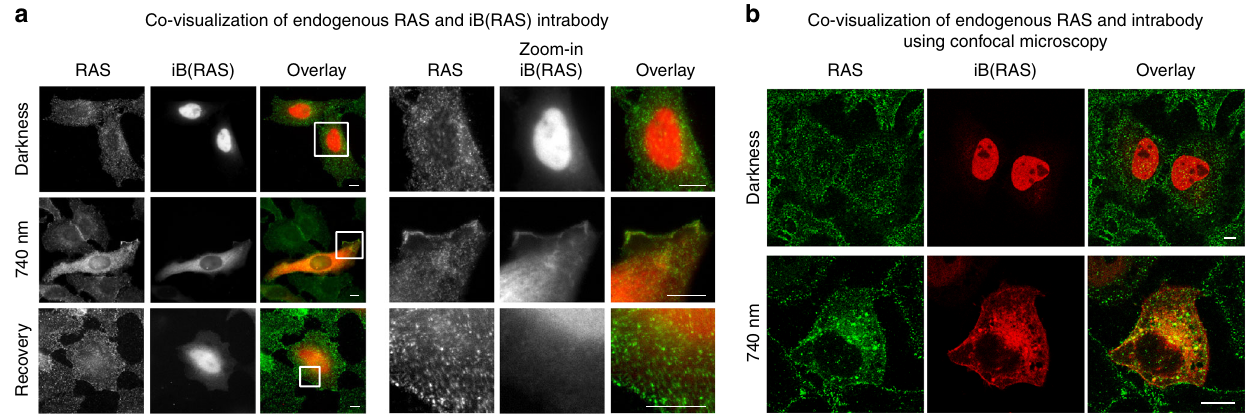
Fig. 7 Covisualization of optically controlled iB(actin) and its endogenous target. a HeLa cells expressing the optically controlled iB(RAS) (shown in red) were stained with anti-pan-RAS monoclonal antibodies (green). iB(RAS) has nuclear localization in darkness. Under 740 nm light, it is released from nucleus to cytoplasm and plasma membrane where it is colocalized with endogenous RAS. Zoom in of white frame-marked regions are shown on the right. Epi fl uorescence microscopy; scale bar, 10 µ m. b Cells with the NIR light-triggered release of iB(RAS) imaged using confocal microscopy. Scale bar, 10 µ